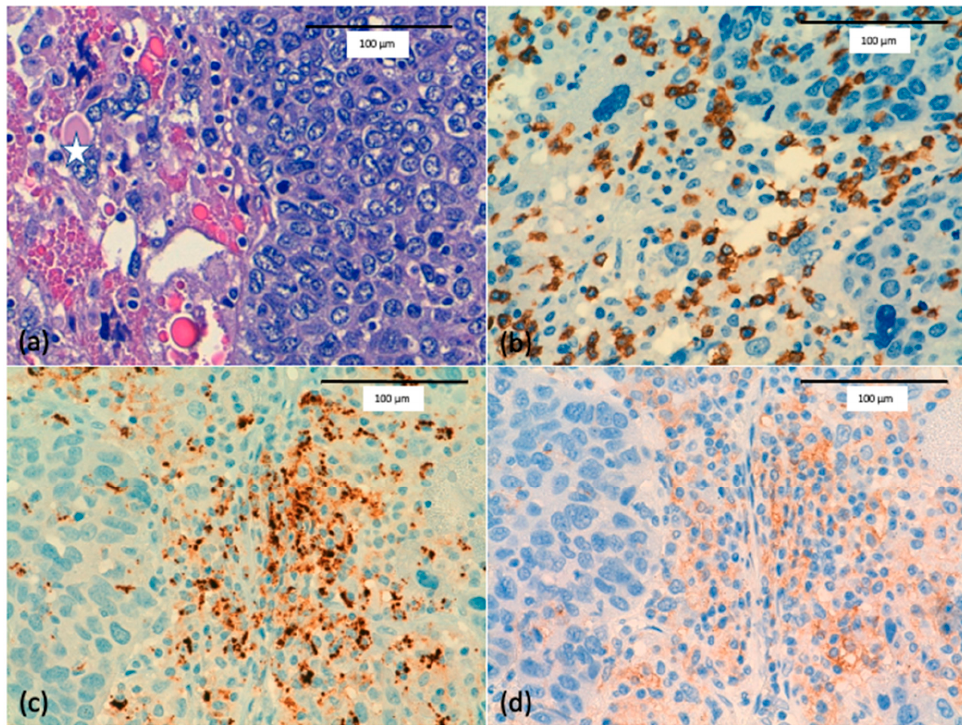
Figure 6. ( a ) Metaplastic breast cancer with a mesenchymal pleomorphic component (start) (scale bar 100 µm). ( b ) CD8 immunostain highlights the intratumoral immune cells in pleomorphic metaplastic breast cancer (scale bar 100 µm). ( c ) Programmed cell death ligand-1 (PD-L1) (SP 142 clone) immunostain showing dark-brown punctate and linear staining mostly expressed in intratumoral immune cells and in sarcomatoid tumoral cells (scale bar 100 µm). ( d ) PD-L1 (22C3 clone) immunostain showing moderate membranous staining in intratumoral immune cells and in sarcomatoid tumoral cells (scale bar 100 µm).